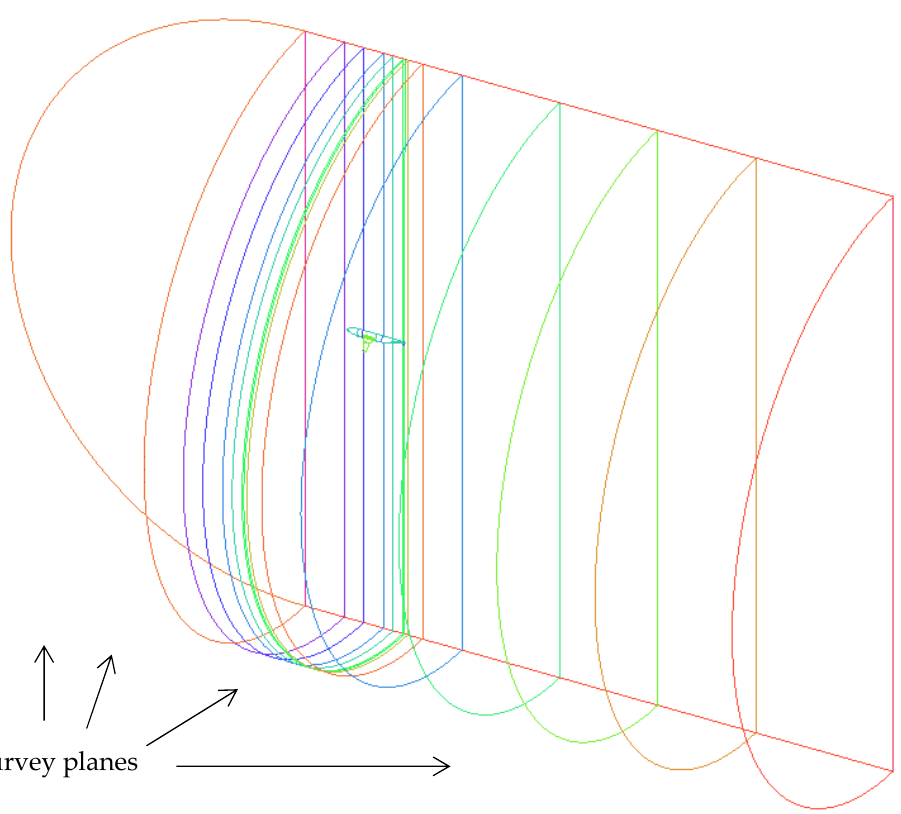
Figure 6. Computational domains segregated by 13 survey planes.